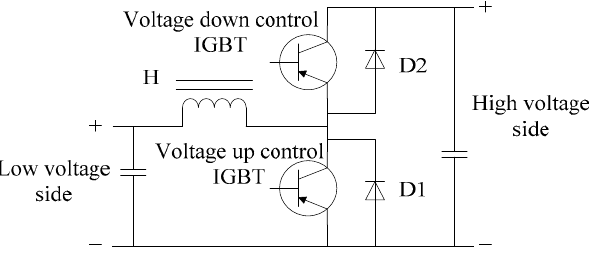
Figure 15. Structure of reversible boost DC/DC. IGBT: insulated gate bipolar